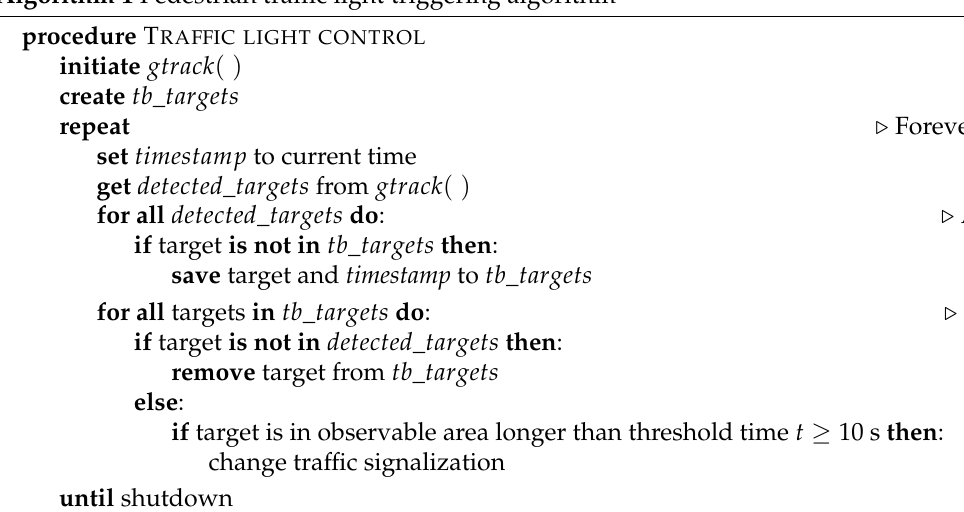
Figure 13. Flow diagram of pedestrian traffic light triggering algorithm. Algorithm 1 Pedestrian traffic light triggering